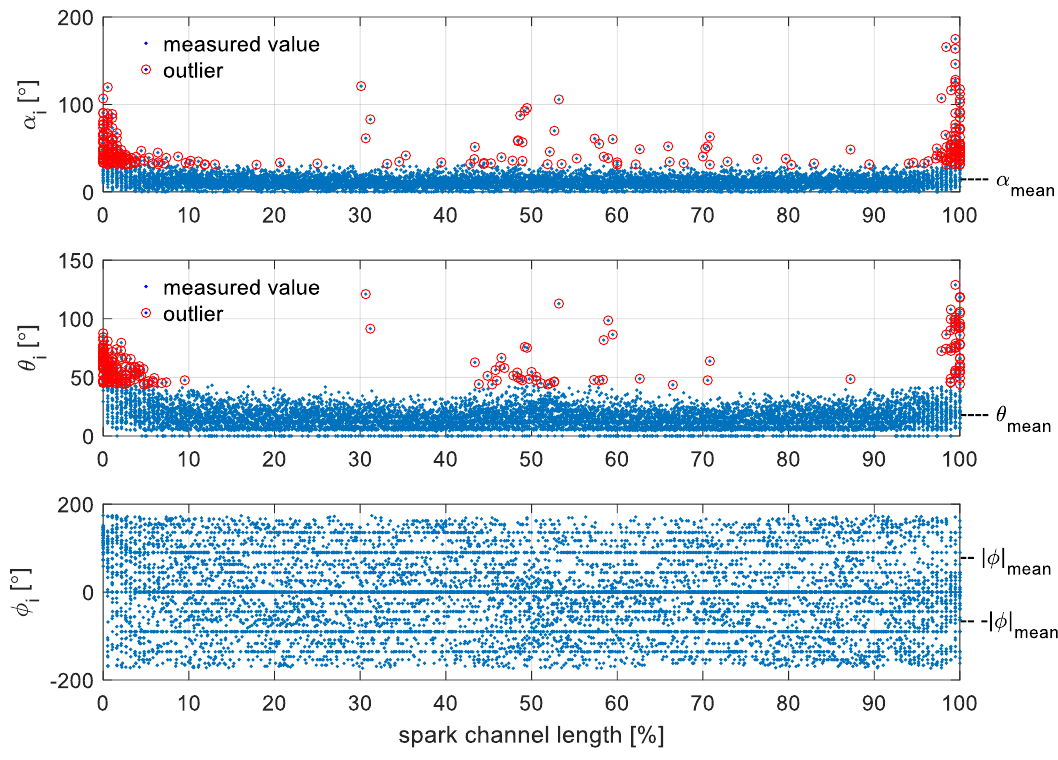
Figure 7. Distribution of angles α i , θ i , and ϕ i along the discharge channel for lightning impulse. with positive polarity, sphere-sphere electrode system, 5.5 m distance between electrodes; computational segment adopted: 0.50% of the discharge channel length.